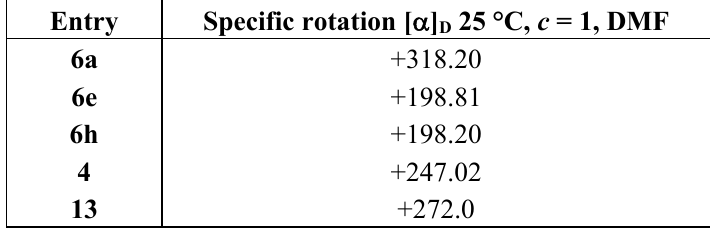
Table 3. Specific rotation for some of the synthesized compounds.